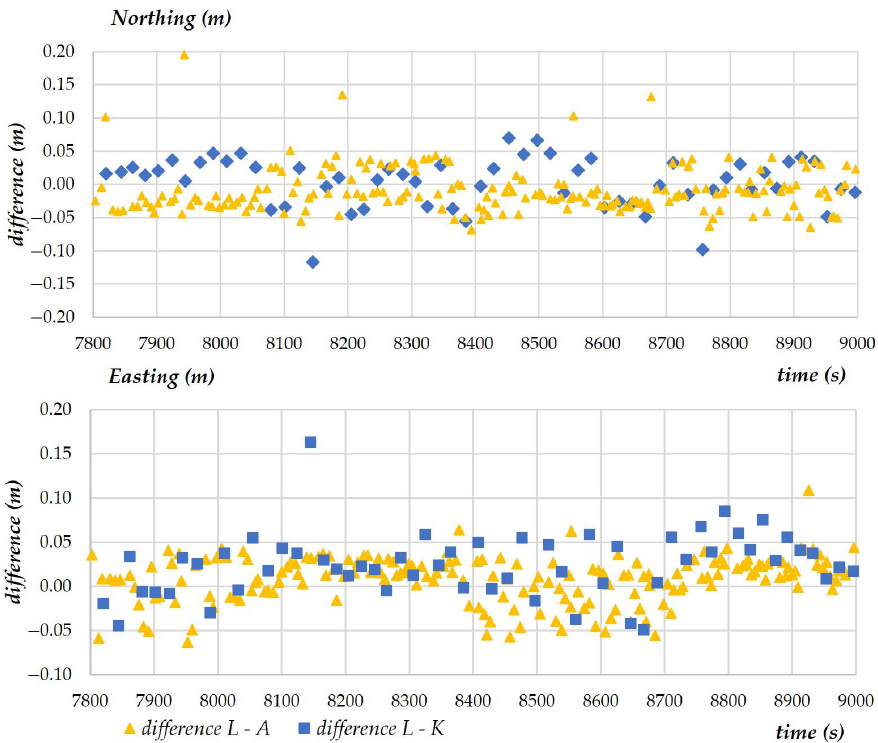
Sensors 2023 , 23 , x FOR PEER REVIEW 17 of 22 Figure 13. Variations in the differences between the coordinates measured by the UAV and registered in the AIRDATA application (L) and the coordinates measured by tachometers (A) and (K).